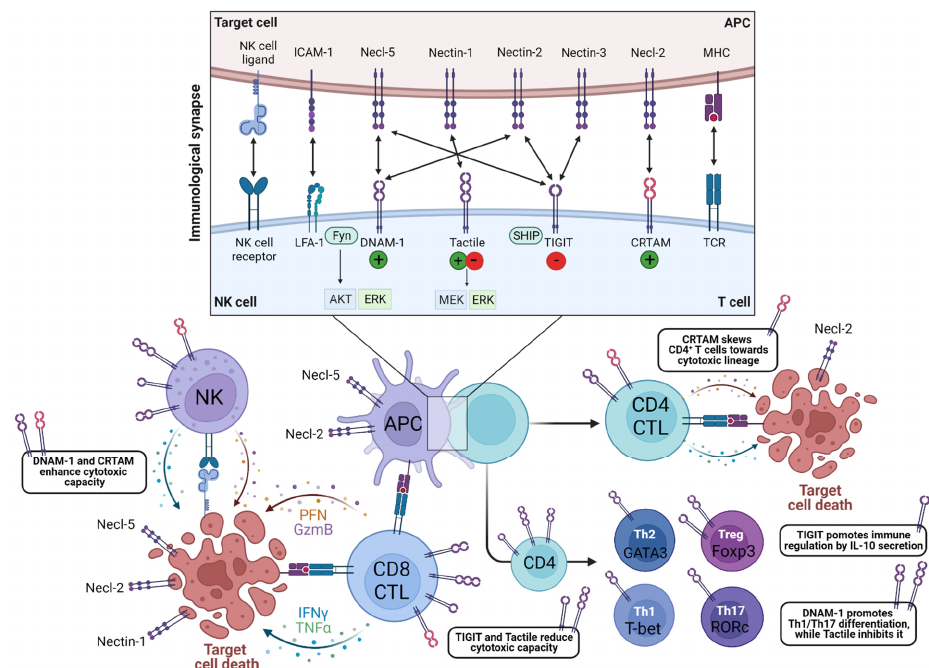
Figure 1. Overview of DNAM-1-, CRTAM-, Tactile- and TIGIT-triggered immune effector functions. The immunological synapse (IS) is formed between a T lymphocyte and APC or between cytotoxic cells and their target cell, as a result of TCR/MHC interaction or NK cell receptor binding, enabling long-lasting cell contact. DNAM-1 co-localizes with LFA-1 and protein kinase Fyn at the IS, which is crucial in the formation of a stable IS and supports granule polarization in cytotoxic cells. Besides enhancing a targeted cytotoxic response towards ligand-expressing target cells, DNAM-1 contributes to the activation, proliferation and differentiation of Th1 and Th17 cells. CRTAM is transiently expressed by activated T cells and NK cells and regulates pro-inflammatory cytokine production and cytotoxicity. CRTAM expression skews CD4 + T cells towards a cytotoxic lineage. CRTAM–Necl-2 interaction supports IS formation and a targeted cytotoxic response. On the contrary, Tactile expression reduces the cytotoxic function of CD8 + CTLs, suppresses a pro-inflammatory phenotype of CD4 + T cells and supports NK cell adhesion at the IS. TIGIT carries out immunosuppressive effects by competing with DNAM-1 for its ligands, leading to suppression of proliferation, differentiation, cytotoxicity by increasing the production of IL-10. APC, antigen presenting cell; CRTAM, class- I-restricted T-cell-associated molecule; CTL, cytotoxic T lymphocyte; DNAM-1, DNAX accessory molecule 1; GzmB, granzyme B; ICAM-1, intercellular adhesion molecule 1; IFN γ , interferon gamma; IL, interleukin; LFA-1, Lymphocyte function-associated antigen 1; MHC, major histocompatibility complex; NK, natural killer cell; Necl, Nectin-like molecule; PFN, perforin; Tactile, T-cell-activated increased late expression; TCR, T-cell receptor; Th, T helper cell; TIGIT, T-cell immunoreceptor with Ig and ITIM domains; TNF α , tumor necrosis factor alpha. Created with Biorender.com (accessed in January